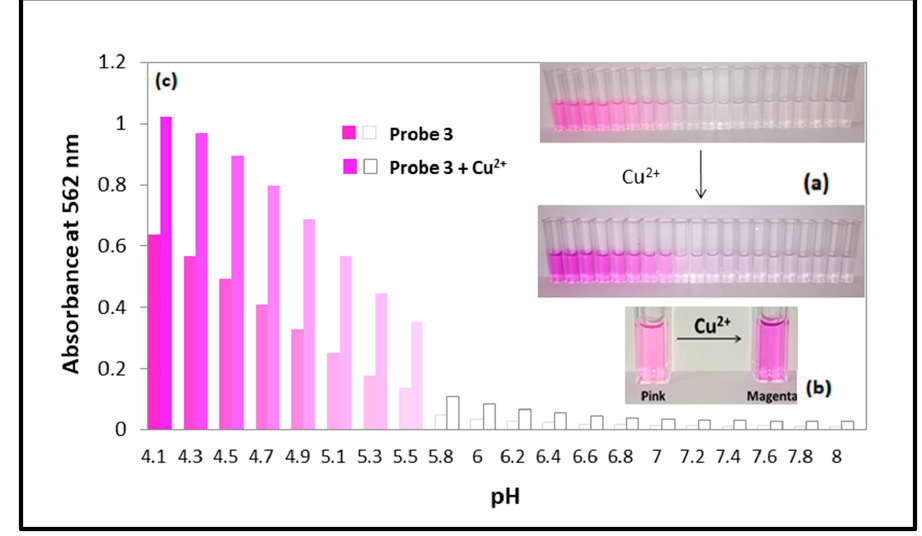
Figure 1. ( a ) Inset images showing the color change of 1 × 10 –4 M Probe 3 alone (upper image) and in the presence of 1 × 10 –4 M copper (lower image) at various pH conditions ranging from 4.1 to 8 (left to right in both), as well as the color intensity variation with changing the pH conditions. ( b ) Inset